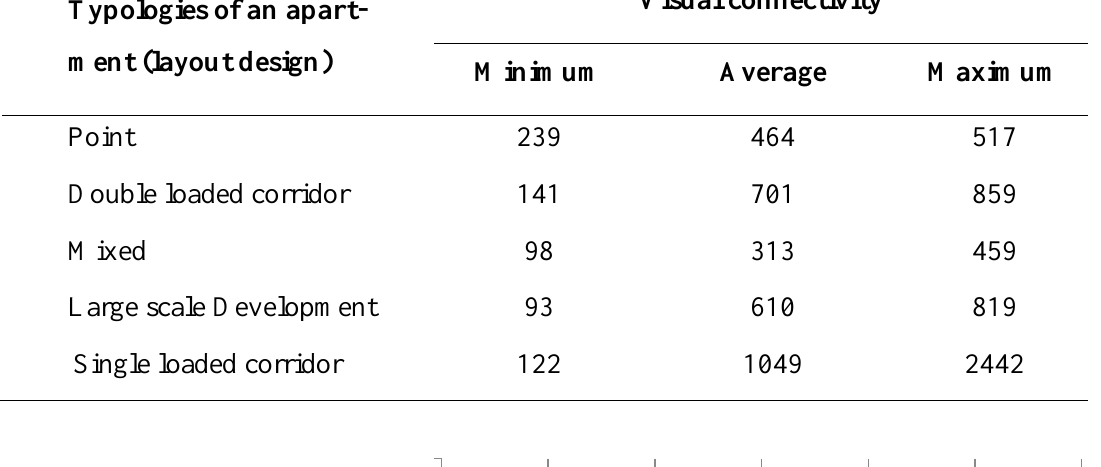
Table 2 . Summary of visual connectivity results of all cases study Typologies of an apart-